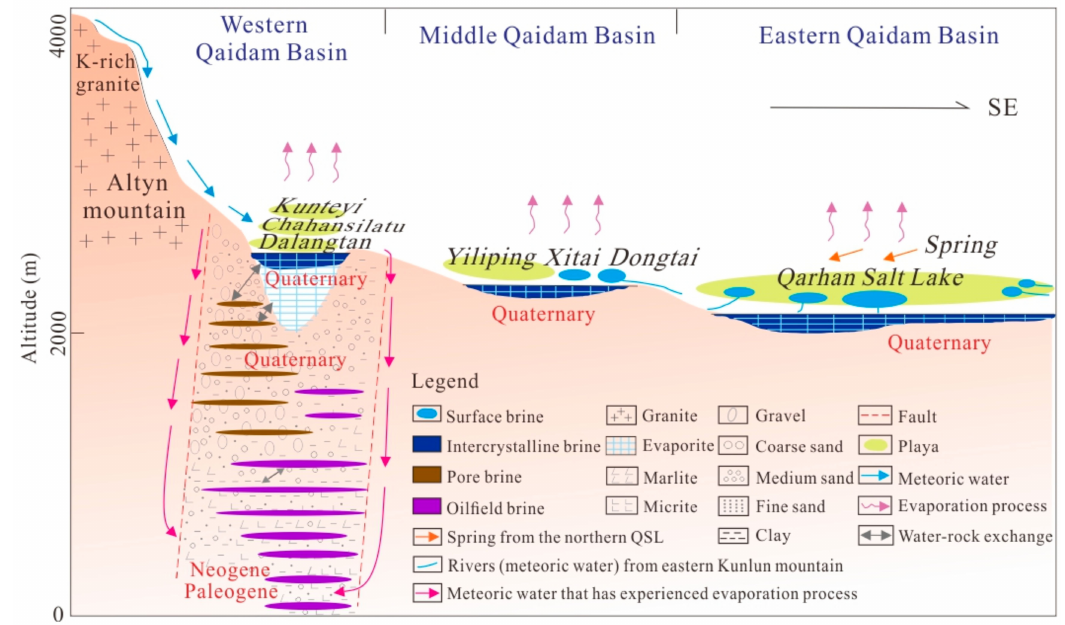
Figure 2. Distribution and origins of di ff erent types of K-rich brines in the QB.